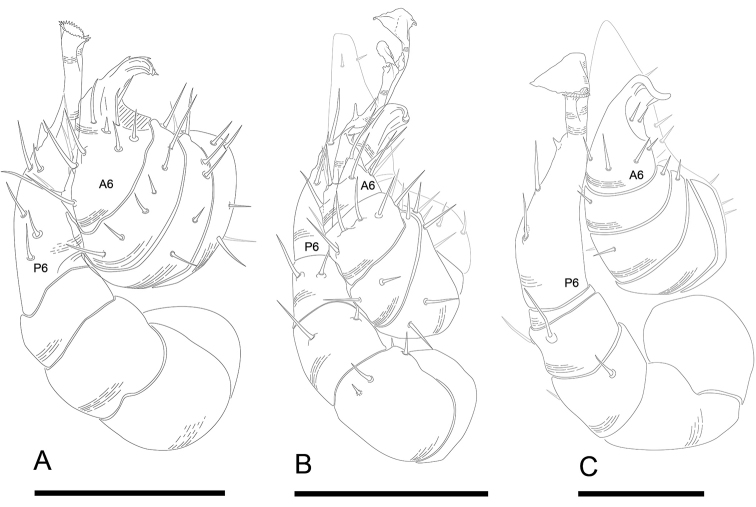
Andrognathus gonopods, ventral view of left gonopods. AAndrognathuscorticarius (podomeres A1, A2 missing) BAndrognathushoffmaniCAndrognathusgrubbsi sp. n. A6: anterior gonopod podomere 6. P6: posterior gonopod podomere 6. Scale bars: 0.1 mm(A, B), 0.05 mm (C).